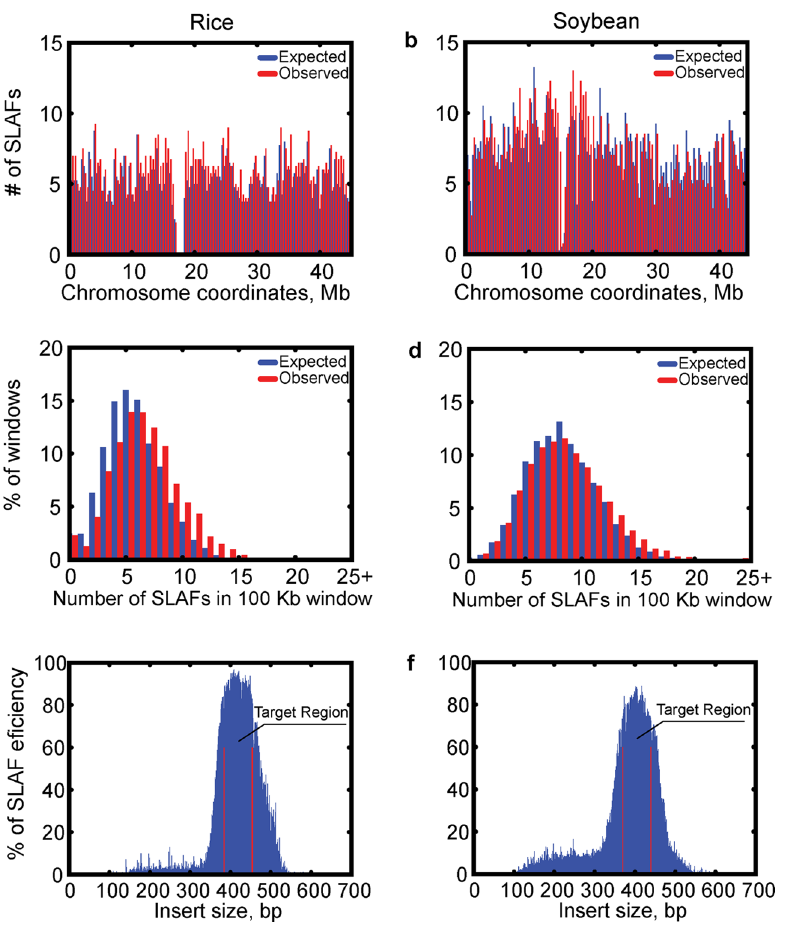
Figure 2. Pilot SLAF-seq data analysis using rice and soybeans. (a)and(b) Insert size distribution of SLAFs. SLAF length was found to cluster tightly around a mean of 430 bp, with 85% of SLAFs in the centermost 50 bp. (c) and (d)Distribution of SLAFs on the chromosomes. SLAFs were evenly distributed on the chromosomes in rice and soybeans. The gap in the middle was caused by the absence of centromere sequences. (e)and(f) Customized SLAF density design. In the rice pilot case, the density was designed using 20 kb per SLAF. In soybeans, 40 kb per SLAF was used. Both rice and soybean pilot SLAF data were found to be consistent with theoretical predictions.